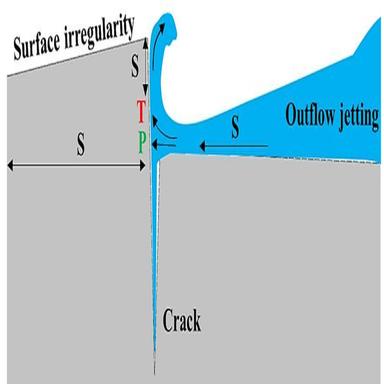
Remade schematic of stress produced at a surface elevation along a crack by the radial flow from a droplet.